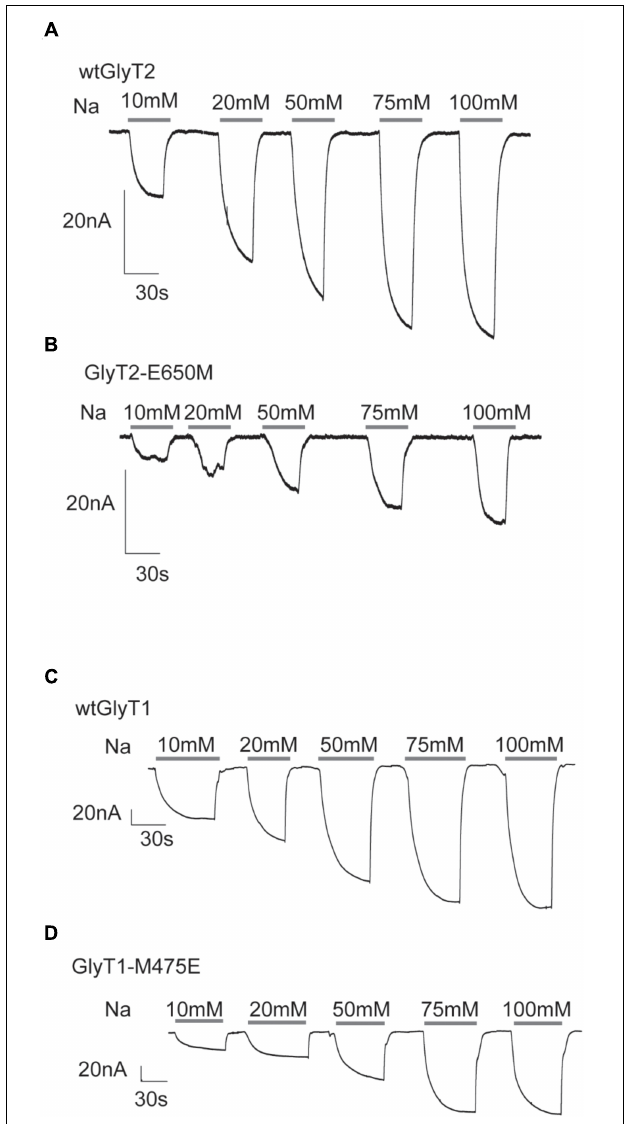
FIGURE 4 | Glycine-associated currents of GlyT2 and GlyT1 substitution mutants at different external sodium concentrations. (A–D) Inward currents recorded at a holding potential of –60 mV elicited by application of 1 mM glycine at the indicated sodium concentrations (extracellular NaCl concentrations isotonically substituted by choline chloride) in four representative oocytes expressing the indicated